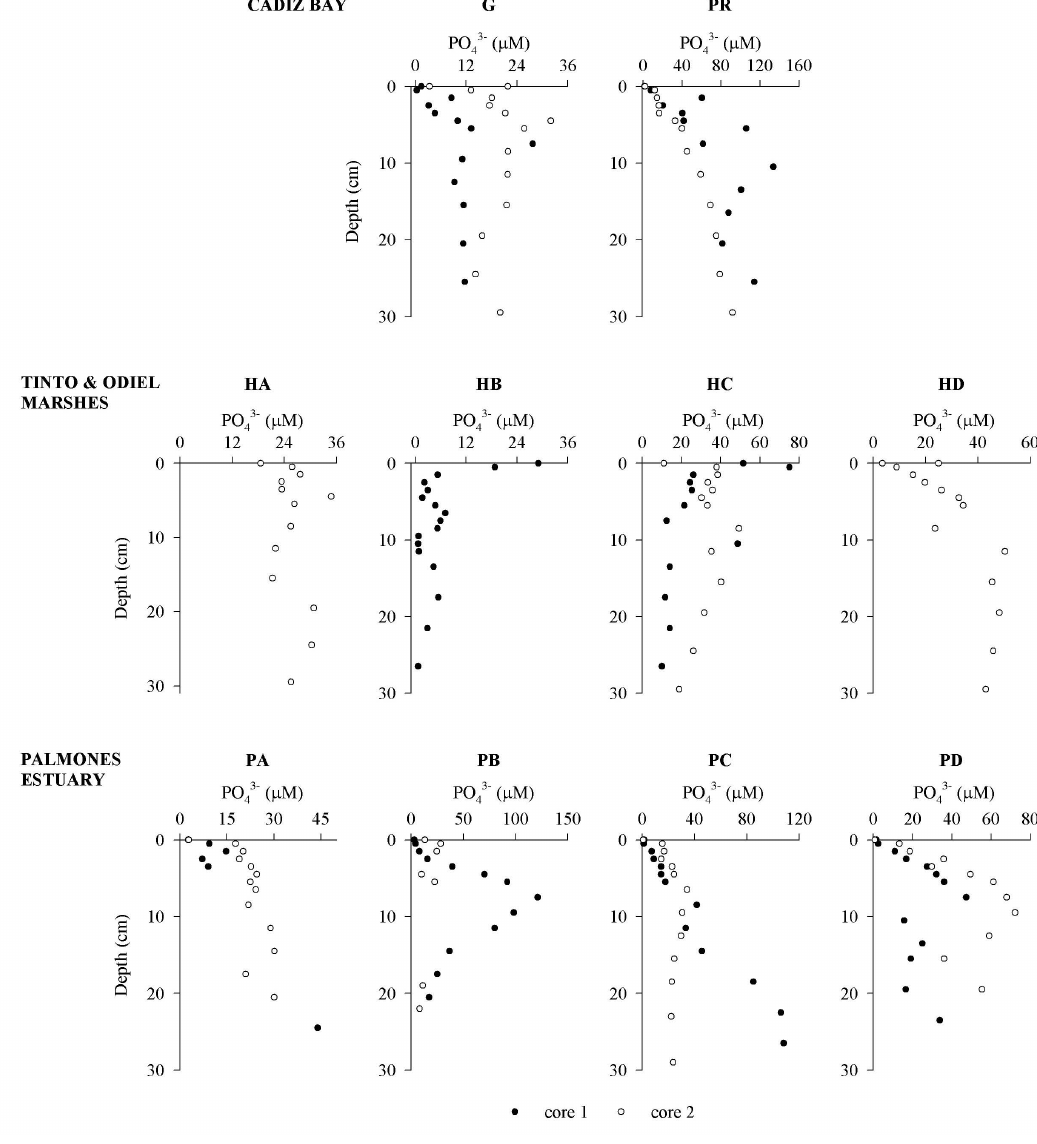
Fig . 3. – Vertical profiles of phosphate (in µM) in interstitial water at each